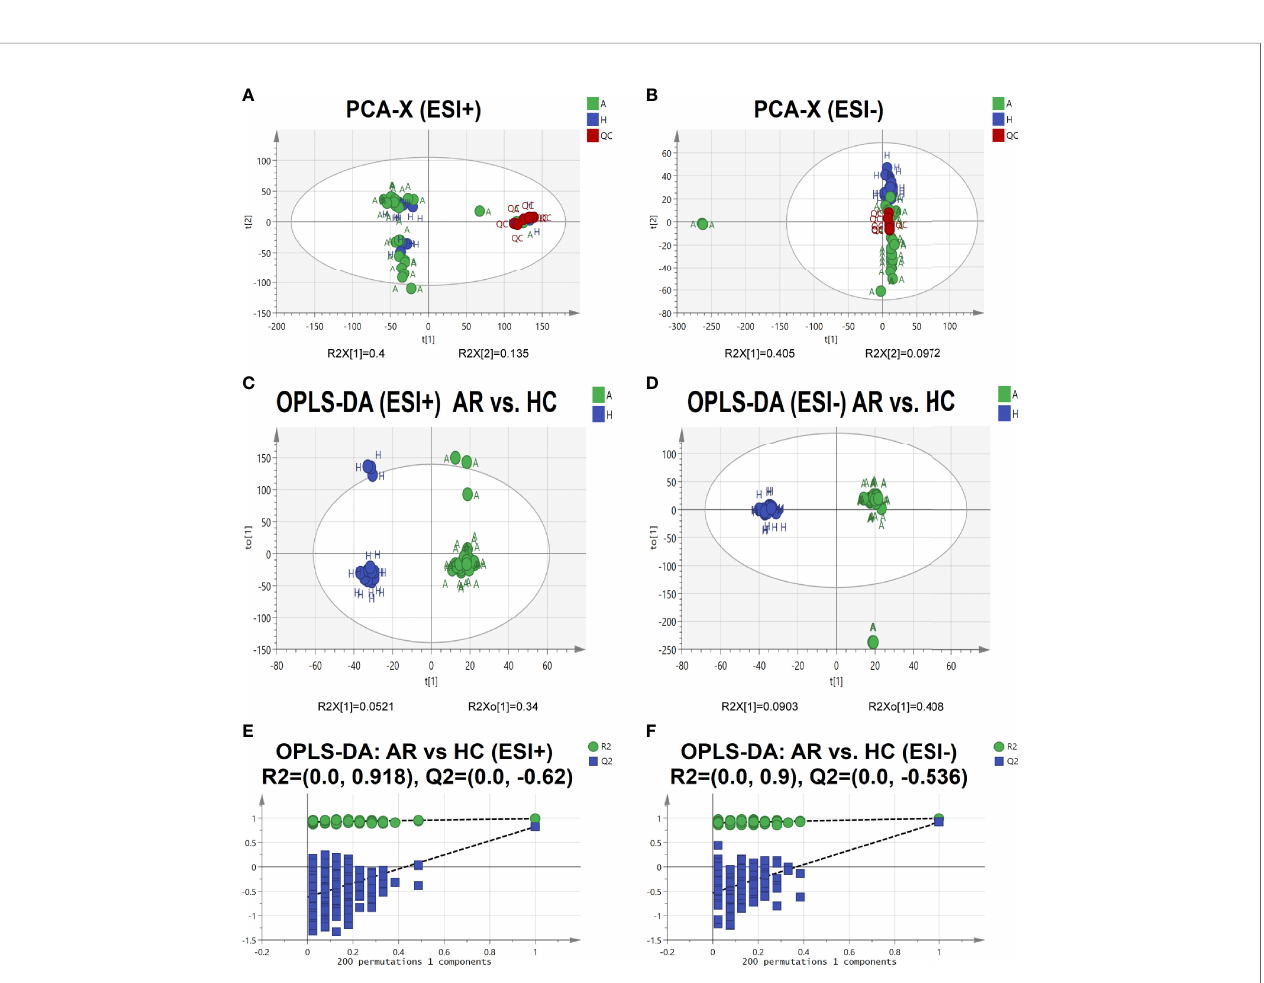
FIGURE 5 | Serum metabolomic pro fi le in different groups. (A, B) PCA score plots of serum metabolic pro fi ling of allergic rhinitis and healthy control groups. (C, D) OPLS-DA score plots of serum metabolic pro fi ling of AR and HC groups. (E, F) The permutations plots of the OPLS-DA